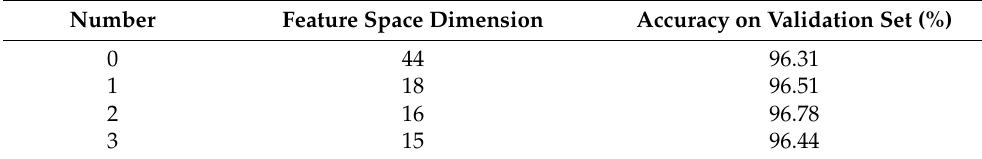
Table 4. The process of feature dimensionality